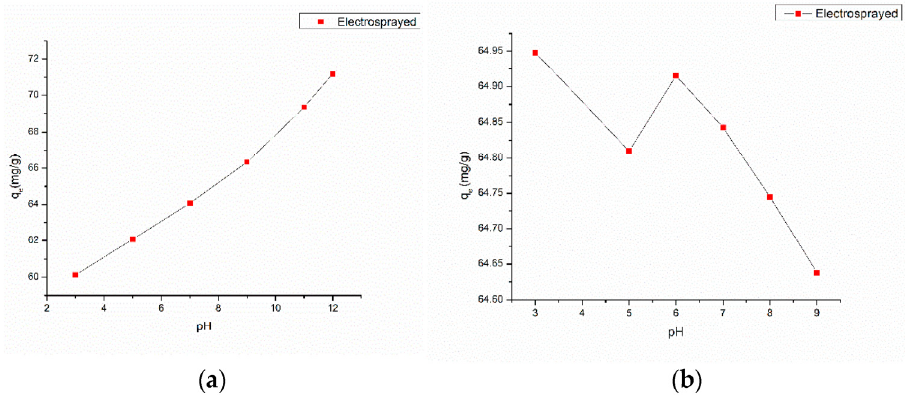
Figure 7. Absorption capacity of ( a ) MB and ( b ) CR as a function of pH at contact time = 48 h, adsorbent dosage = 5 mg, and temperature = 300 K.